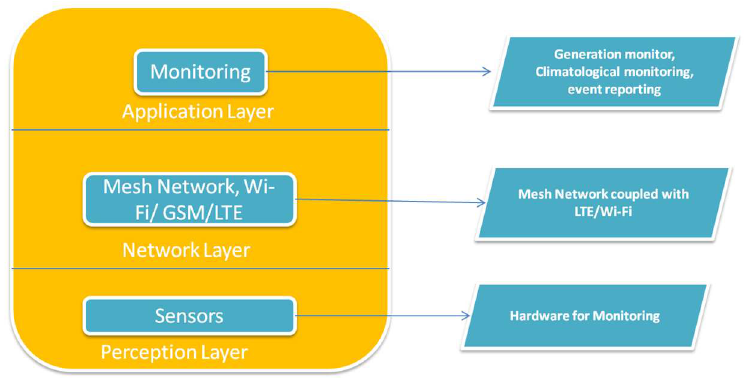
Figure 3. Structure of the communication network.